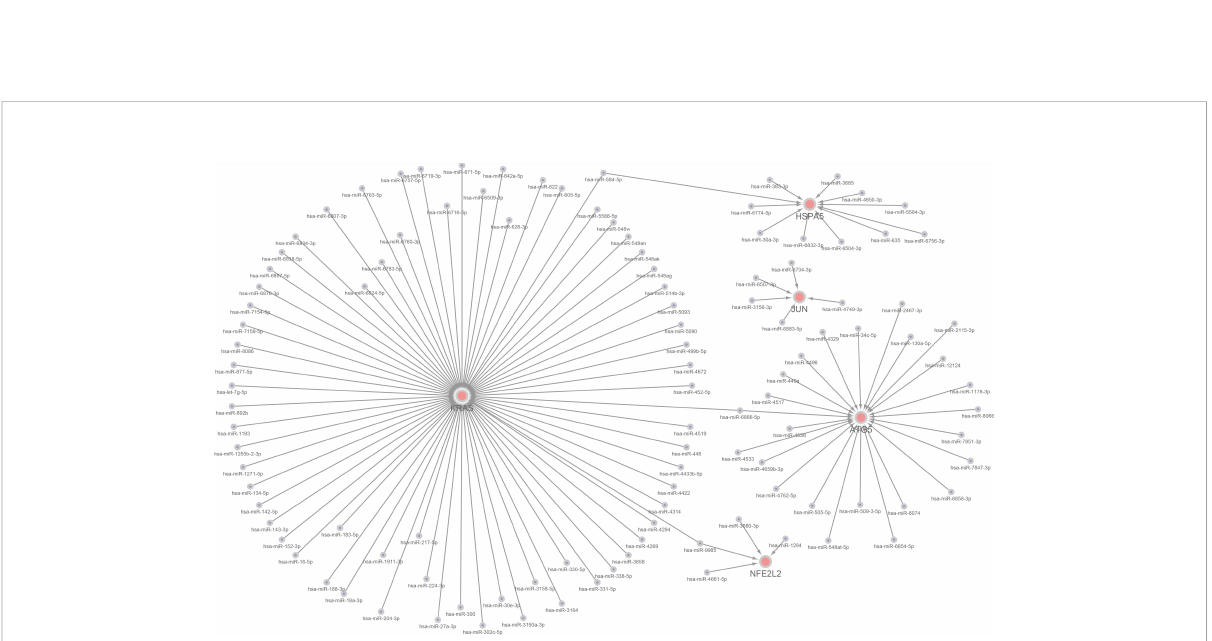
FIGURE 10 A miRNA – hub gene regulatory network construction in diabetic islets. Interaction network between hub genes and its targeted miRNAs. Genes were colored in red, miRNAs were colored in blue. Three higher amounts of cross-linked genes including hsa-miR-6855-5p, hsa-miR-9985, and